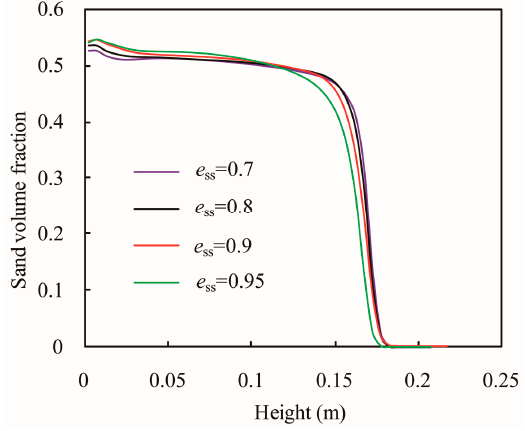
Figure 16. Axial profiles of the time-averaged particle volume fraction of the jetsam.